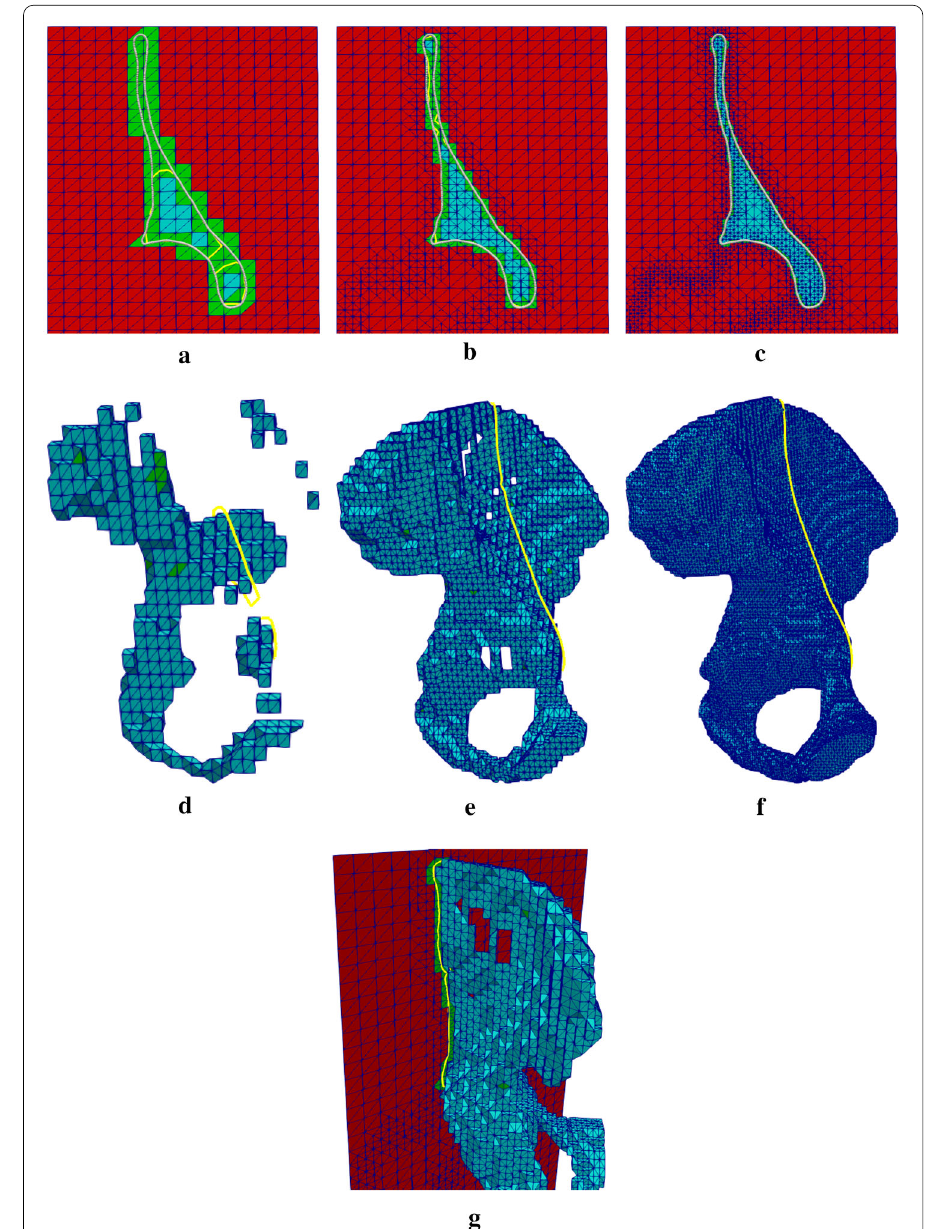
Fig. 6 Linear approximation of the hip bone surface triangulation in regular background mesh with two refinement steps of all elements which collide with the surface triangulations of the hip and femur bone. The figures a – c show elements marked as interior as blue, marked as colliding with green and marked as outside with red. The figures d – f shows all the elements which are fully inside the hip bone geometry